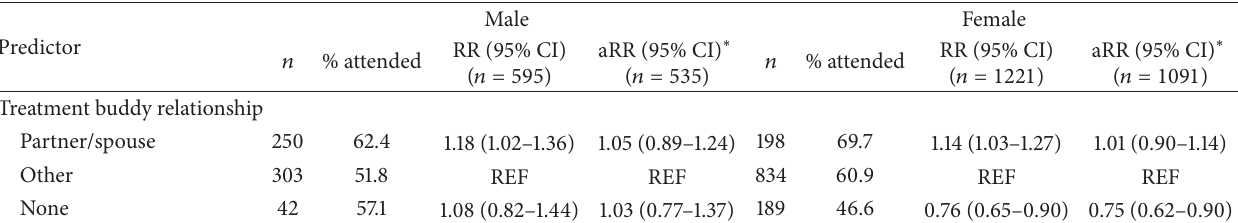
Table 4: Adjusted relative risks for factors associated with clinic attendance during the first six months on ART including relationship to TBy, by